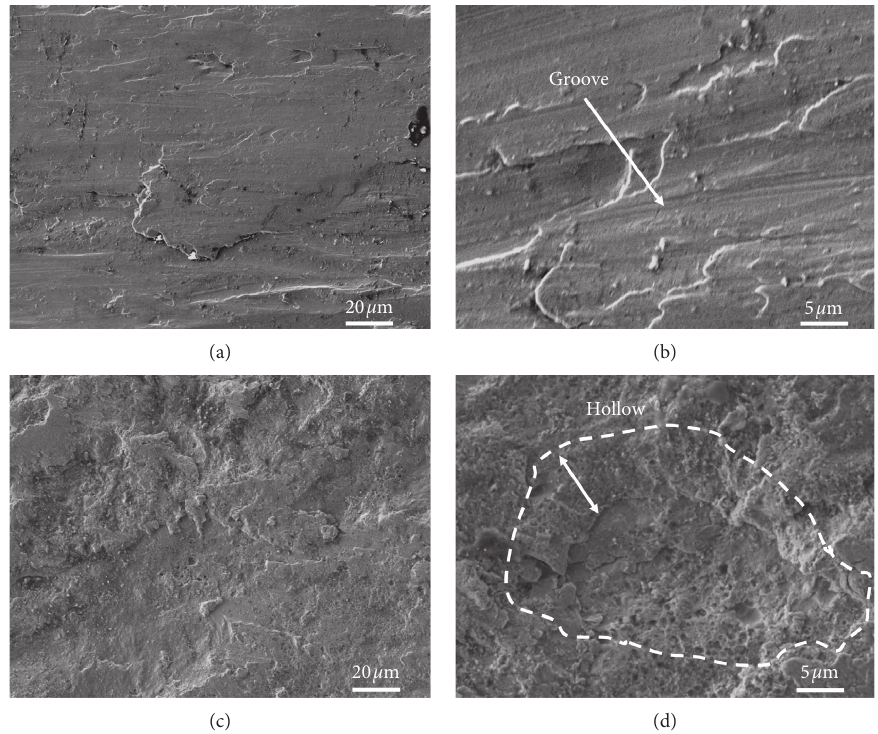
Figure 14: SEM images of the wear surfaces of Inconel 625 superalloy after Si (b, d) enlarged views of (a) and